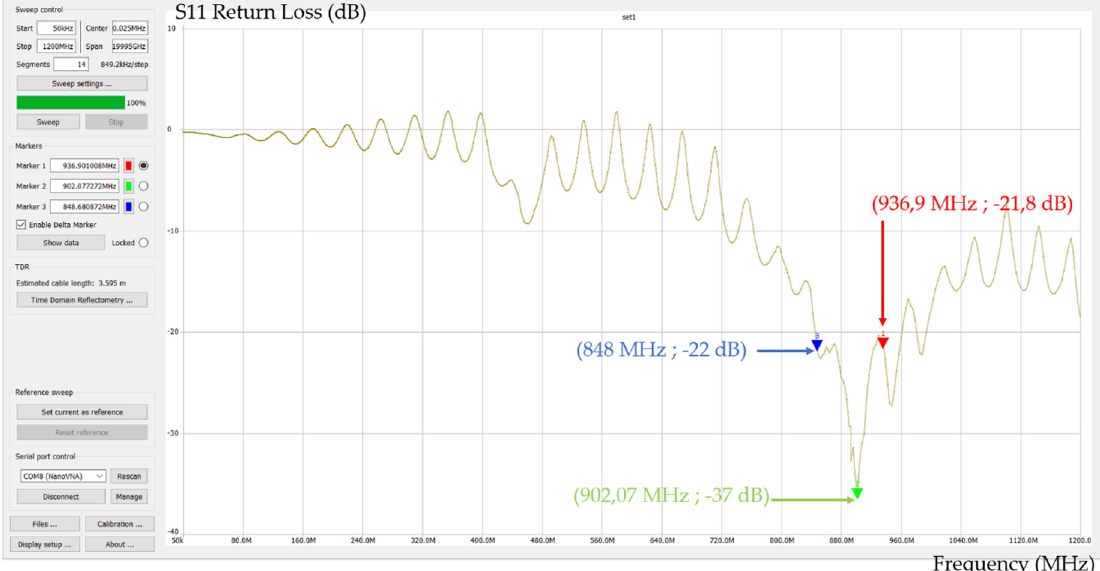
Figure 18. Antenna S11 return loss measured with network analyzer.